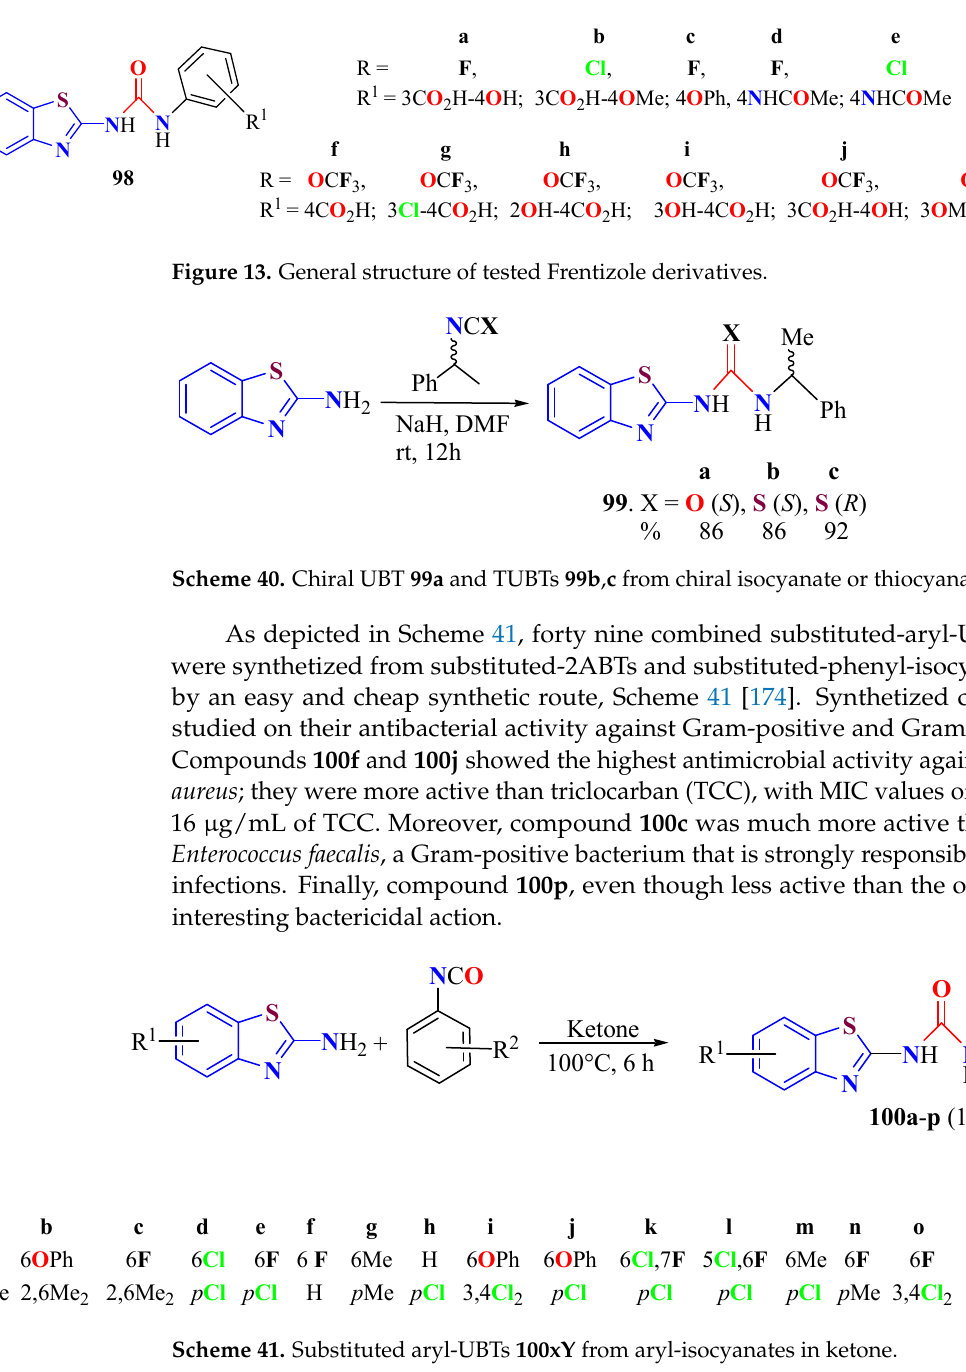
j Compounds 96 Figure 12. Substituted UBTs 96a – zzc and TBT 97 from substituted 2ABTs, CDI, or TCDI and aniline derivatives. Several Frentizole derivatives 98a – k were selected by molecular docking as potential nicotinate mononucleotide adenylyl-transferase (NadD) inhibitors for antimicrobial activ- ity evaluation, Figure 13 [172]. Compounds 98f and 98h – k showed antimicrobial activity